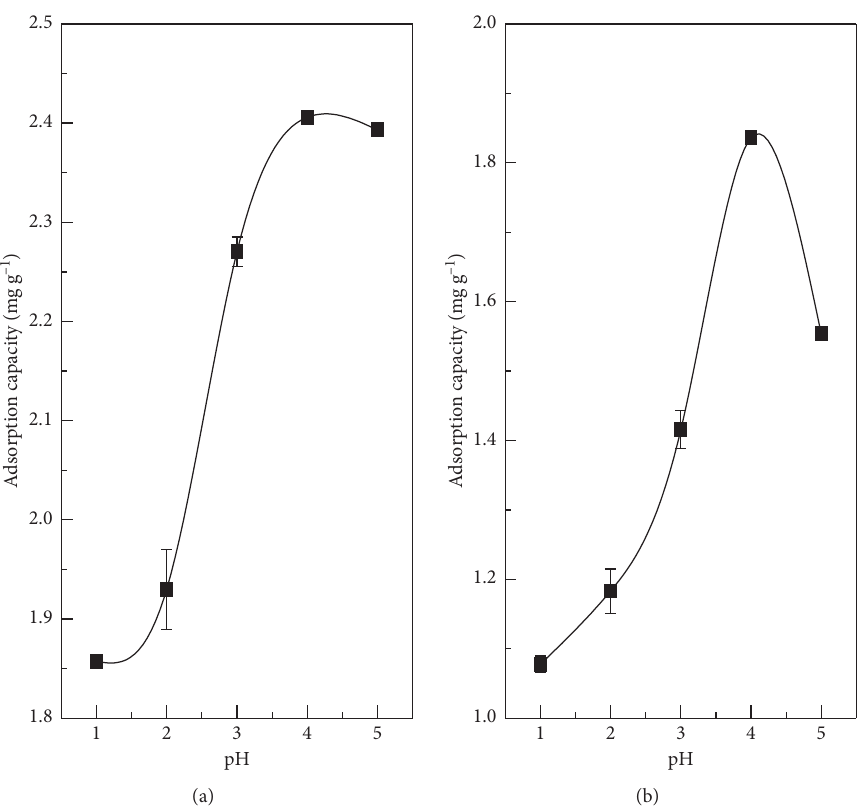
Figure 8: Effect of solution pH on the adsorption of wastewater (a) Cu (II) and (b) Cd (II) by SACL (experimental condition: Cu (II) concentration � 200mg · L − 1 ; Cd (II) concentration � 200mg · L − 1 ; contact time � 180min; amount of adsorbent � 4g; temperature (25 ° C); and agitation speed � 150rpm) (error bars represent the standard deviation of three